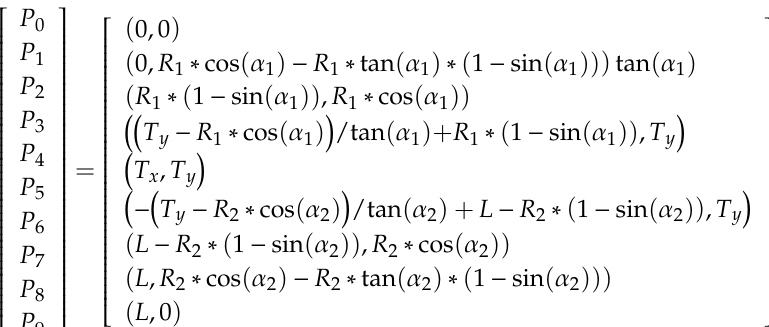
Figure 4. Half-thickness distribution curve parameterization.